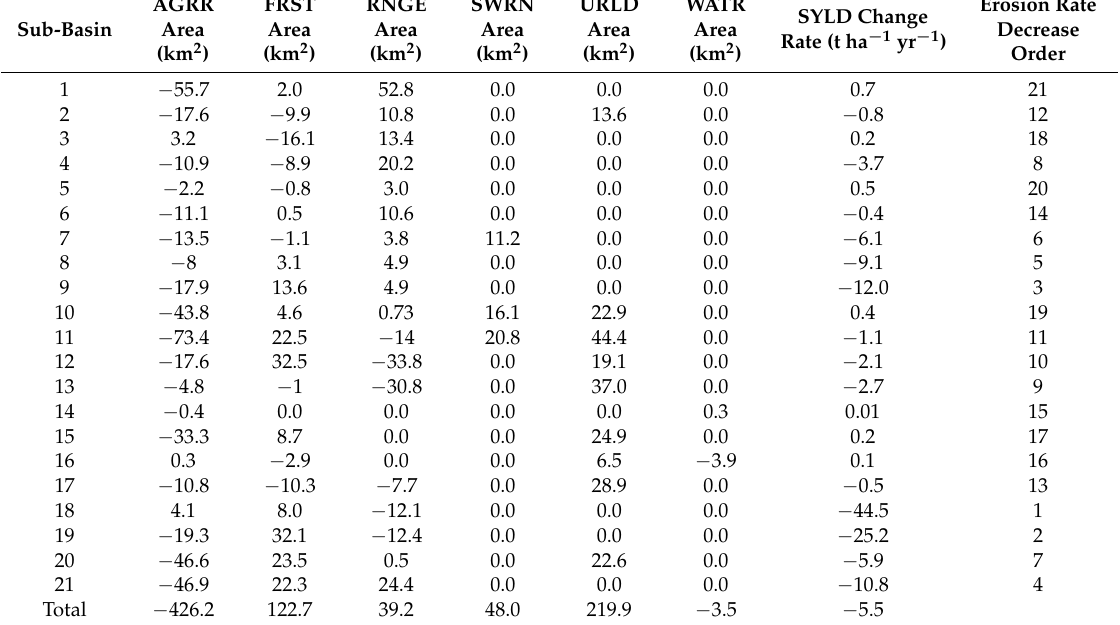
Table 7. The area change of land use in sub-basins of the USK river basin from S 0 to S 1.